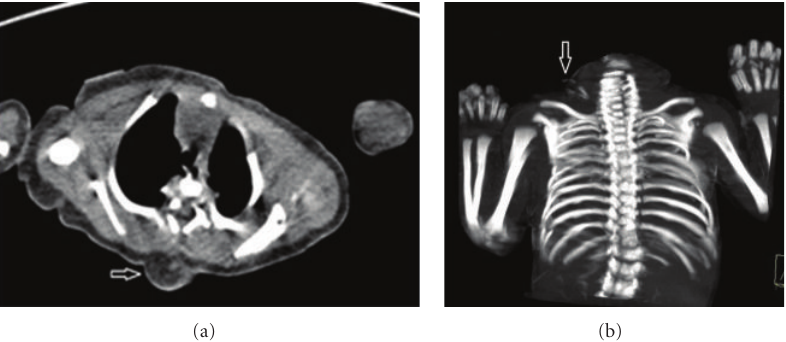
Figure 2: Axial tomographic section (a) shows spina bifida adjacent to the root of the ectopic extremity (arrow). Coronal reformatted image (b) shows two hypoplastic metacarpals and three phalangeal bones of the hand